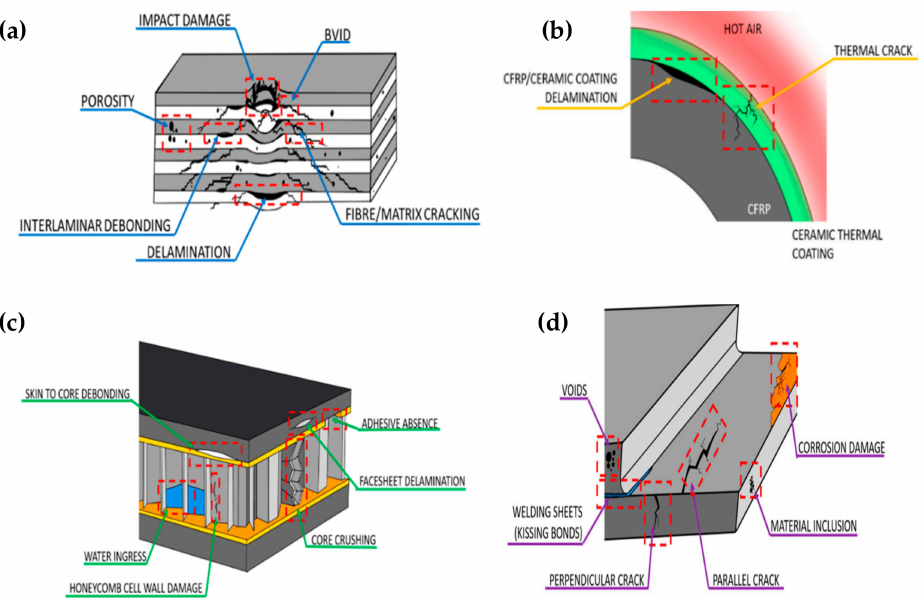
Figure 8. Type of damages in aerospace crafts: ( a ) jet engine turbine blades, ( b ) honeycomb panels, ( c ) metallic aircraft, and ( d ) spacecraft components. Images obtained from Reference